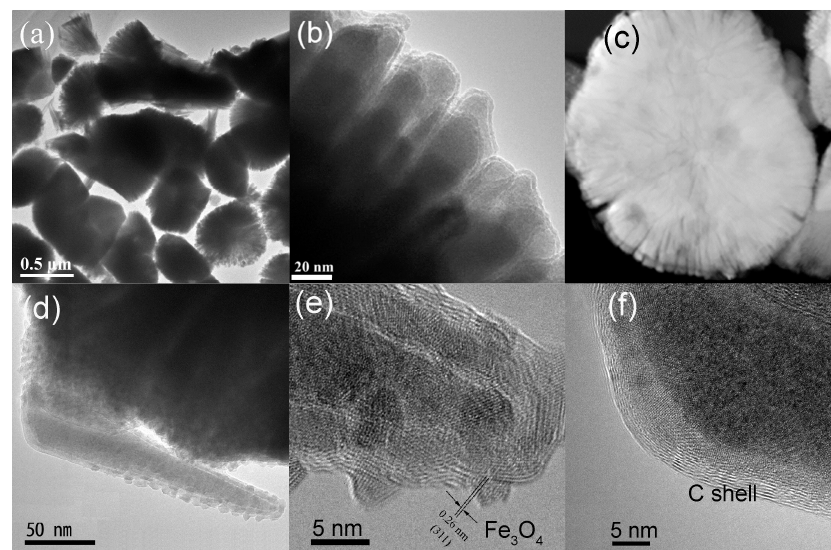
Figure 1. ( a , b ) TEM image and ( c ) HADDF images of α ”-Fe 16 N 2 @C nanocones synthesized at 433 K for six days. ( d ) TEM image for a separate α ”-Fe 16 N 2 @C nanocone and its corresponding HRTEM image for ( e ) Fe 3 O 4 nanocrystals on the surface of the thinner end and ( f ) carbon shell of the thicker